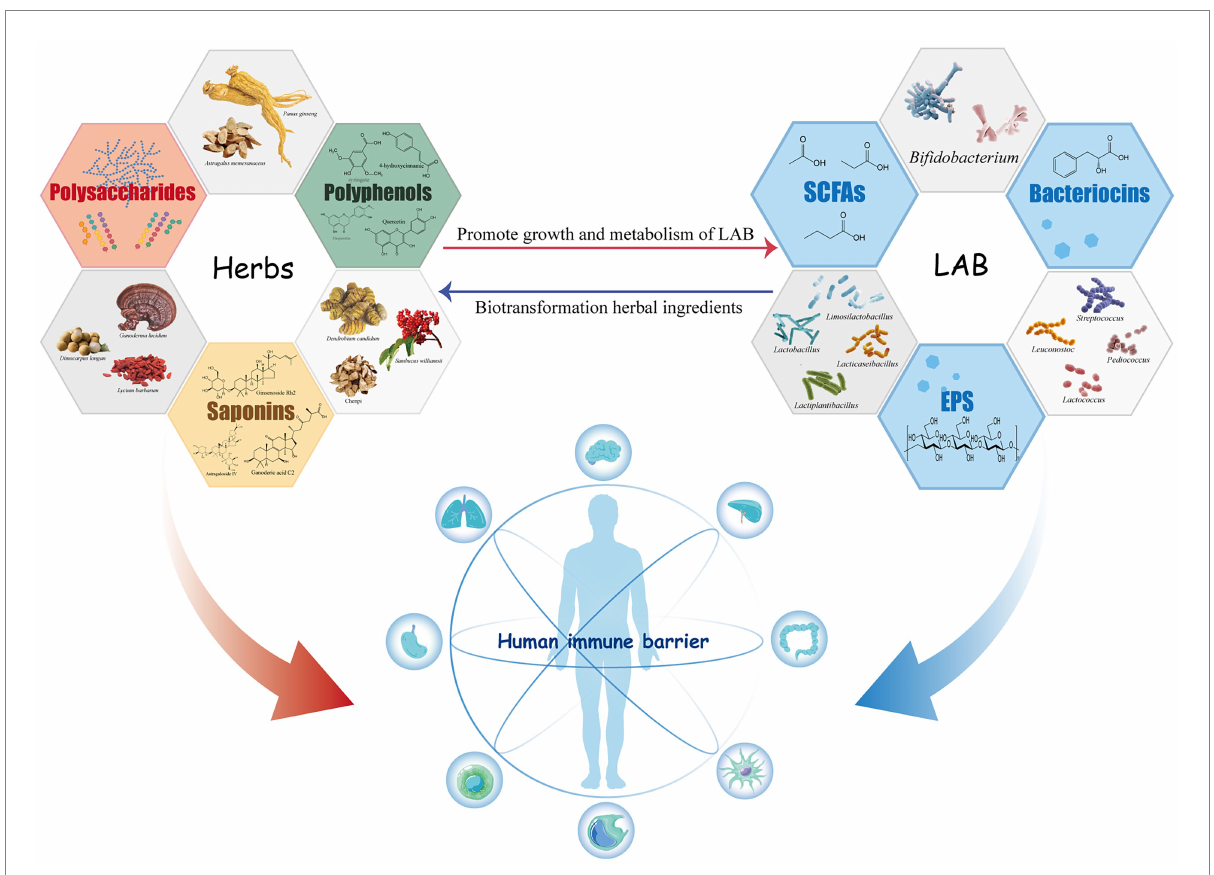
FIGURE 1 Immunomodulatory active components of lactic acid bacteria and herbal medicines and their